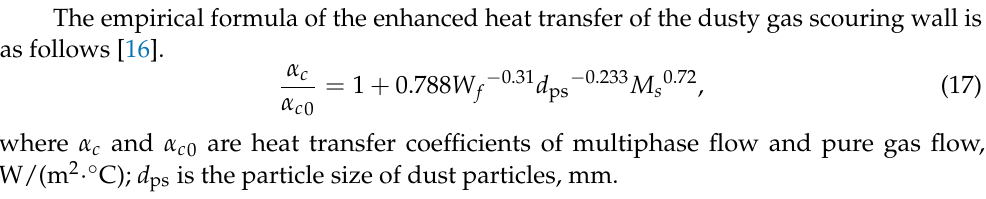
Figure 3. Schematic diagram of particle effect on boundary layer.